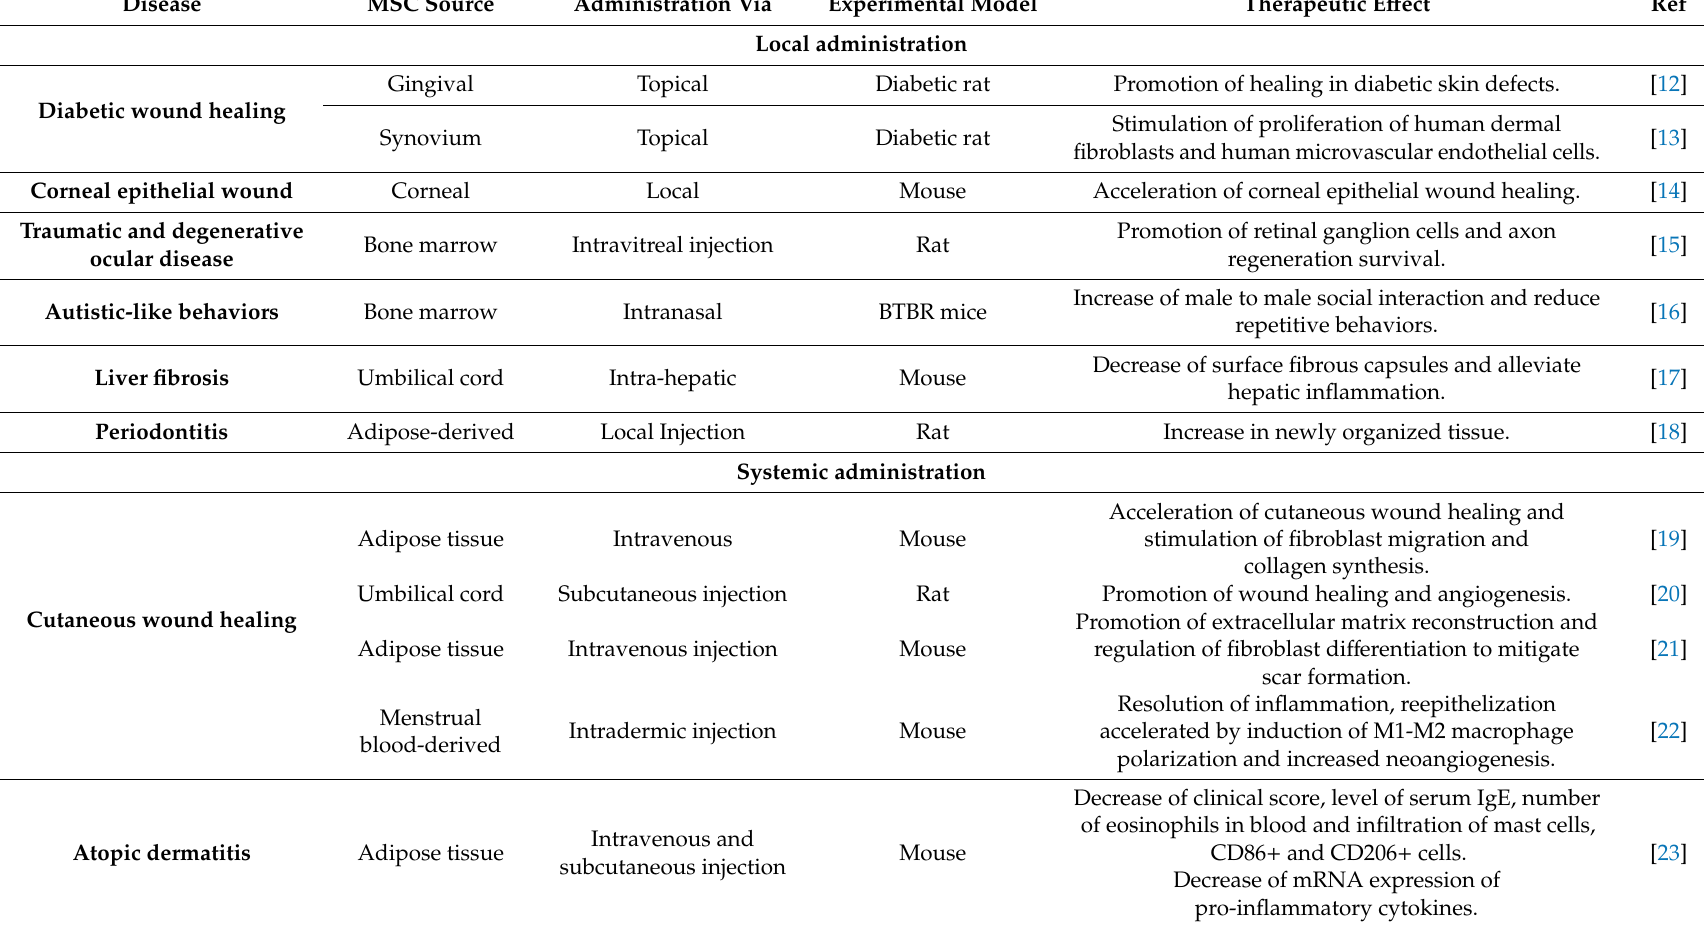
Table 1. Therapeutic e ff ects of mesenchymal stem cell (MSC)-derived exosomes on disease in vivo